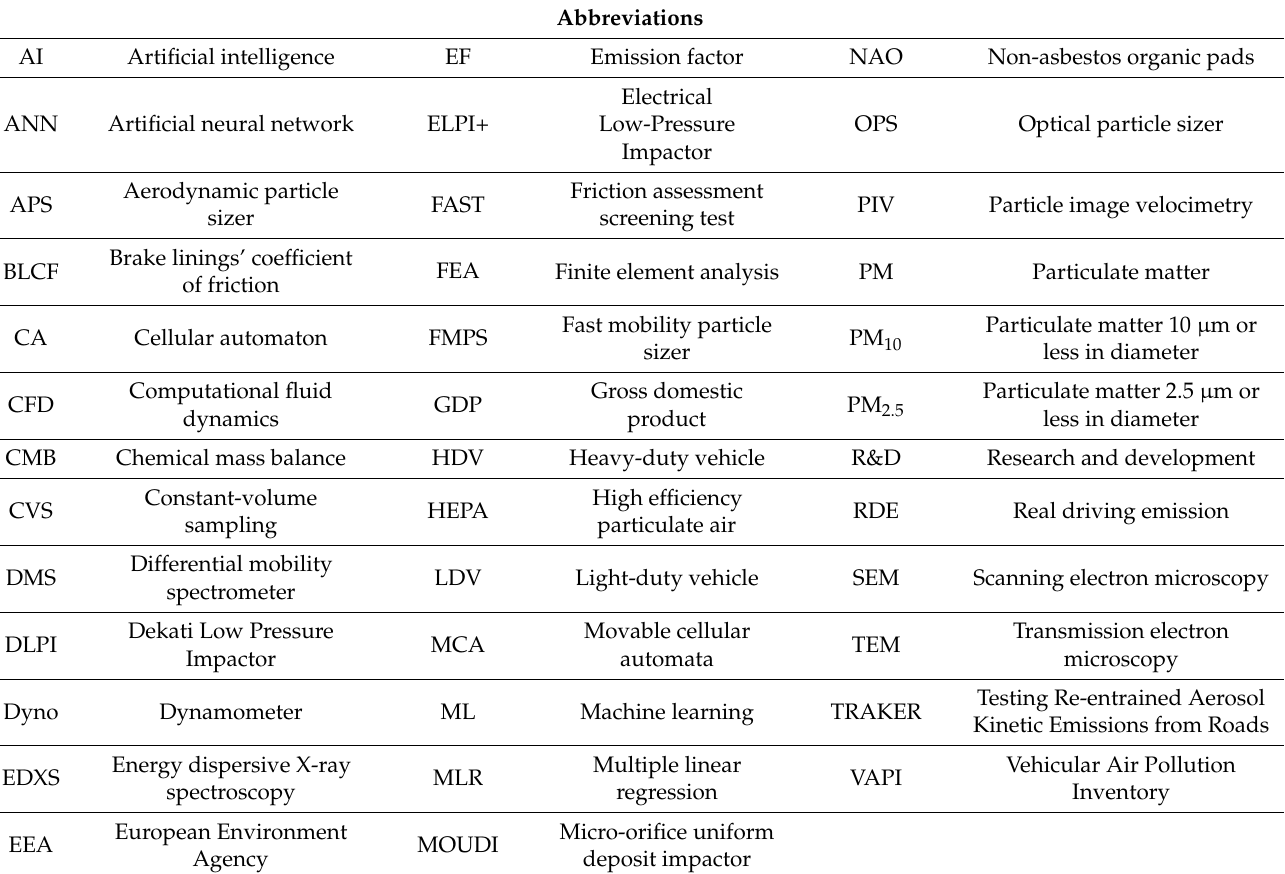
Table 1. Abbreviations used in the